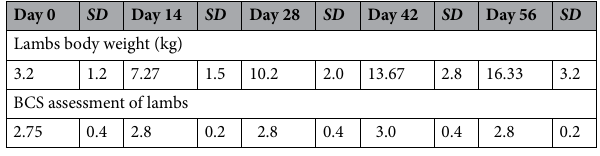
Table 1. Lambs body weight and BCS assessment.